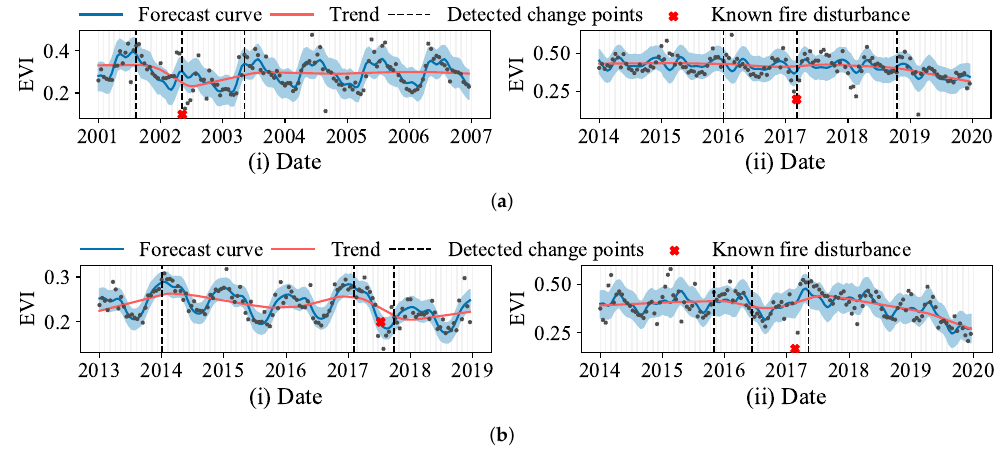
Figure 5. Partial detection results by Prophet model. ( a ) The detection advantages of the Prophet model: ( i ) Detect subtle forest disturbances; ( ii ) can quickly fit changing trends, and detect sudden breakpoints. ( b ) The detection limitations of the Prophet model: ( i ) The uncertainty of the number of change points leads to missing or redundant change points in detection; ( ii ) the model ignores the change points when the trend changes